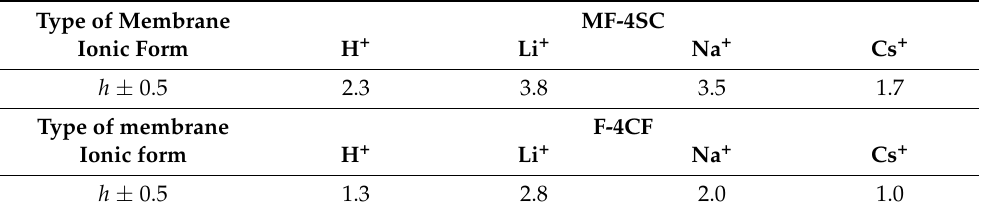
Table 2. Hydration numbers of H + , Li + , Na + and Cs + cations in perfluorinated sulfonate (MF-4SC) and carboxylic (F-4CF) cation exchange